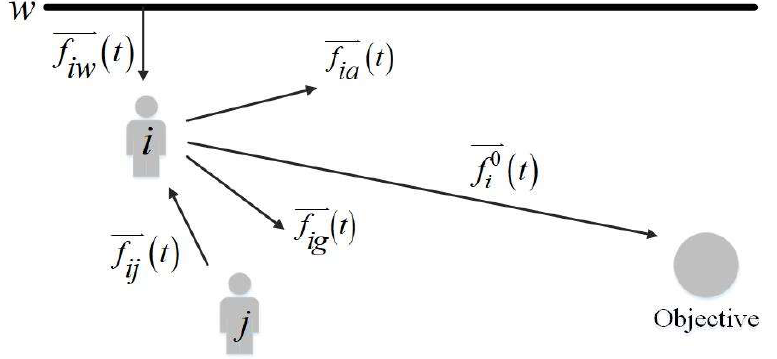
Figure 2. Schematic diagram of social force model.